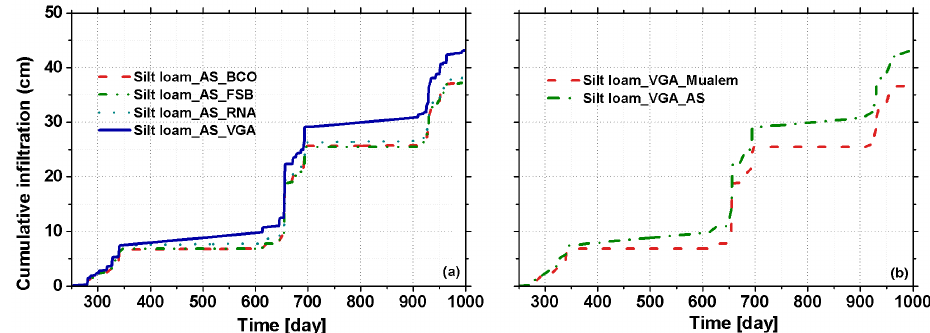
Figure 15. Cumulative infiltration from a silt loam profile for four parameterizations (see Table 1) with the Alexander and Skaggs (1986) conductivity function (a) and for the VGA parameterizations with conductivity functions according to Mualem (1976) and Alexander and Skaggs (1986) (b) .